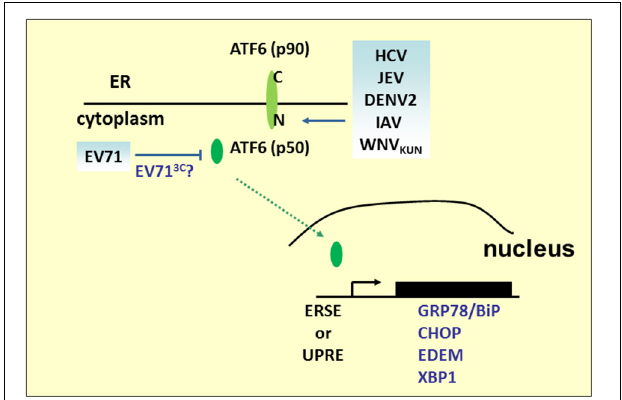
FIGURE 3 | ATF6 pathway under viral infection. Many RNA viruses activate the UPR pathway by cleaving ATF6 to release the p50 fragment. The N-terminal p50 with transcription activity enters the nucleus to activate the expression of ER stress and ERAD genes, such as GRP78/BiP, CHOP, XBP1, or EDEM. However, the p50 fragment was not detected in the EV71